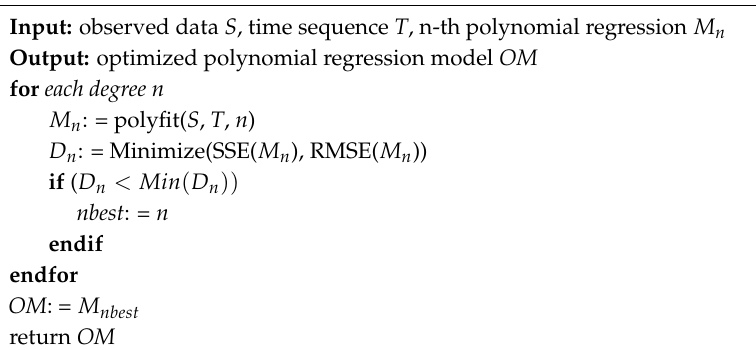
Algorithm 2. Finding best polynomial regression model